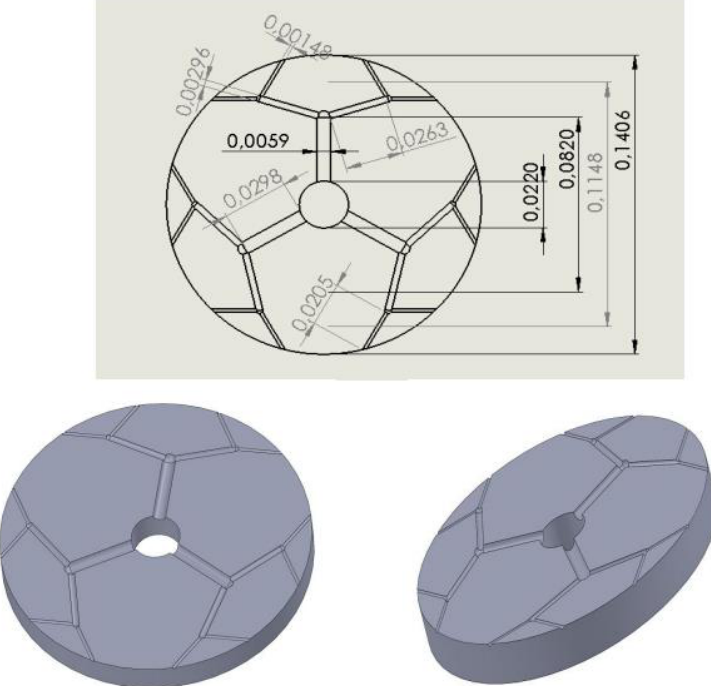
Figure 8. The improved DSHE-C1 (above) and two 3 – D renderings.